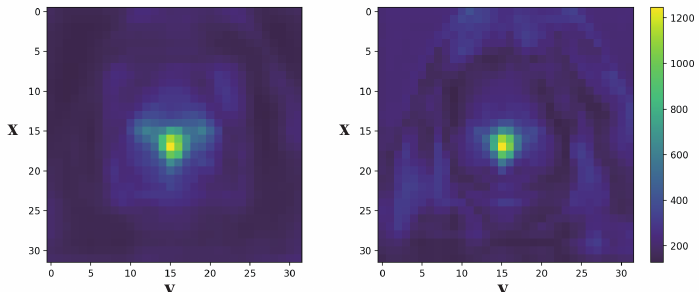
Figure 5. The feature maps before and after attention feature fusion. x and y represent the coordinates of the feature map, and the color bar represents the range of the feature map